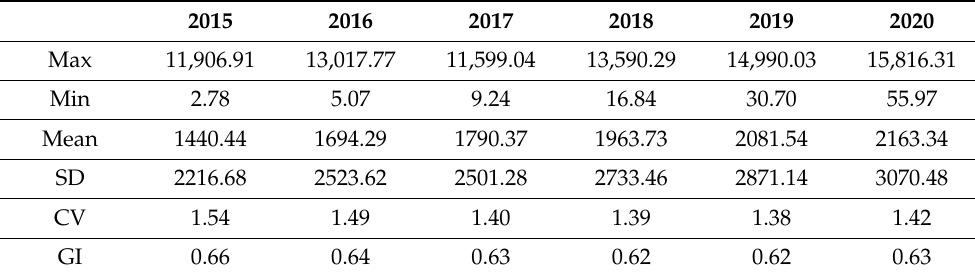
Table 3. Spatial heterogeneity analysis of urban night lighting index in